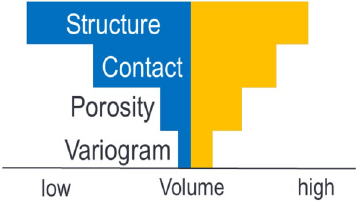
Fig. 4 Tornado diagram showing the impact on uncertainty param‑ eters on reservoir in place